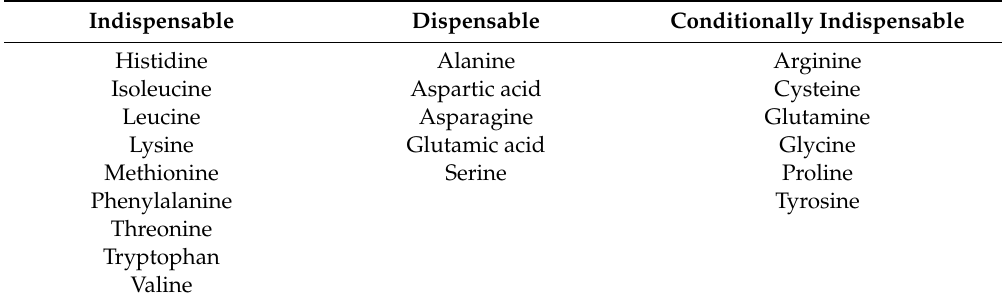
Table 1. Indispensable, dispensable, and conditionally indispensable amino acids in the human diet. Adapted from [11].